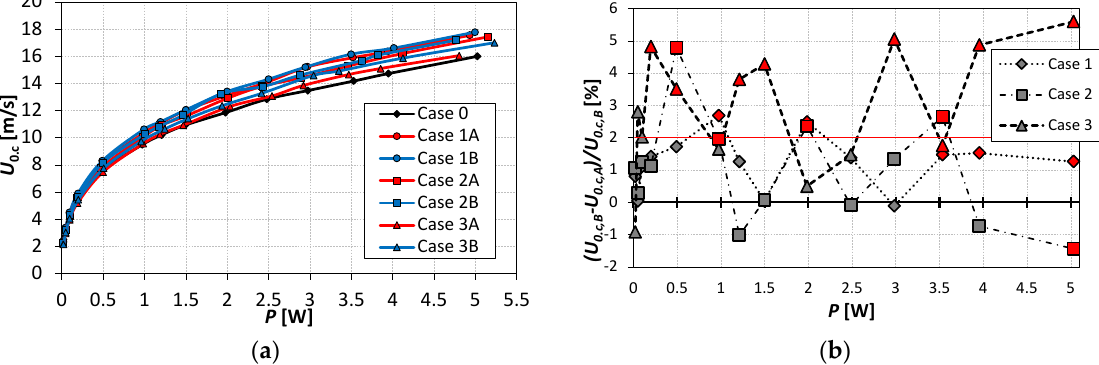
Figure 5. The centerline momentum velocity ( a ), and the percentage difference between the velocity in cases B and A ( b ) as a function of real power, at the characteristic frequency and x = 0.